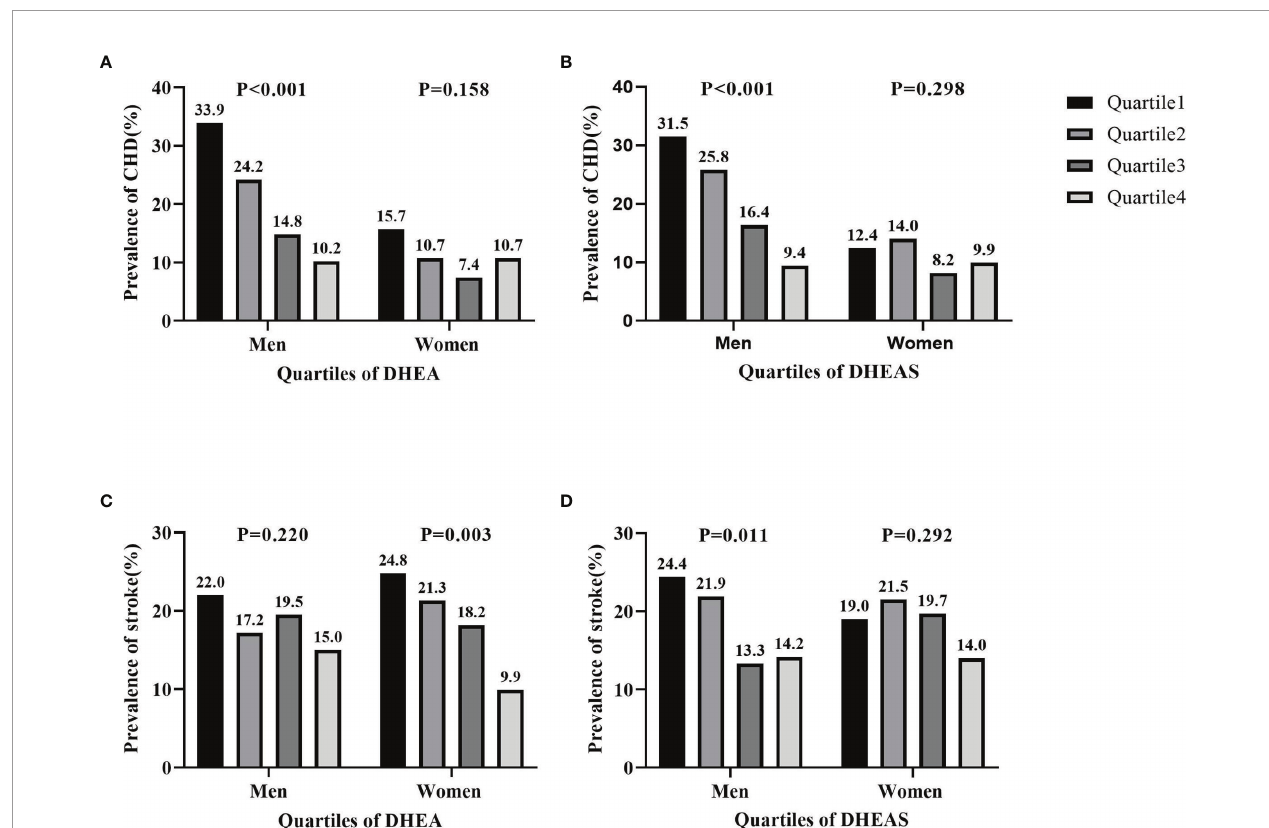
FIGURE 3 | Prevalence of coronary heart disease (CHD) and stroke by quartiles of serum dehydroepiandrosterone (DHEA) and dehydroepiandrosterone sulfate (DHEAS) in men and women. (A, B) Prevalence of CHD by DHEA (A) and by DHEAS ( B ). (C, D) Prevalence of stroke by DHEA (C) and by DHEAS ( D ). The fi gure shows that the percentages of men with CHD signi fi cantly decreased in accordance with increasing quartiles of serum DHEA and DHEAS (all p < 0.001). The prevalence of stroke signi fi cantly decreased in line with increasing quartiles of serum DHEA in women ( p = 0.003) and DHEAS in men ( p =